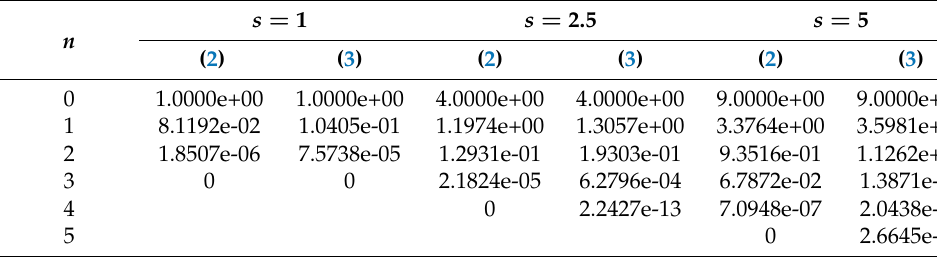
Table 2. The values (cid:107) x n − x ∗ (cid:107) ∞ at each iteration for s = 1, 2.5,